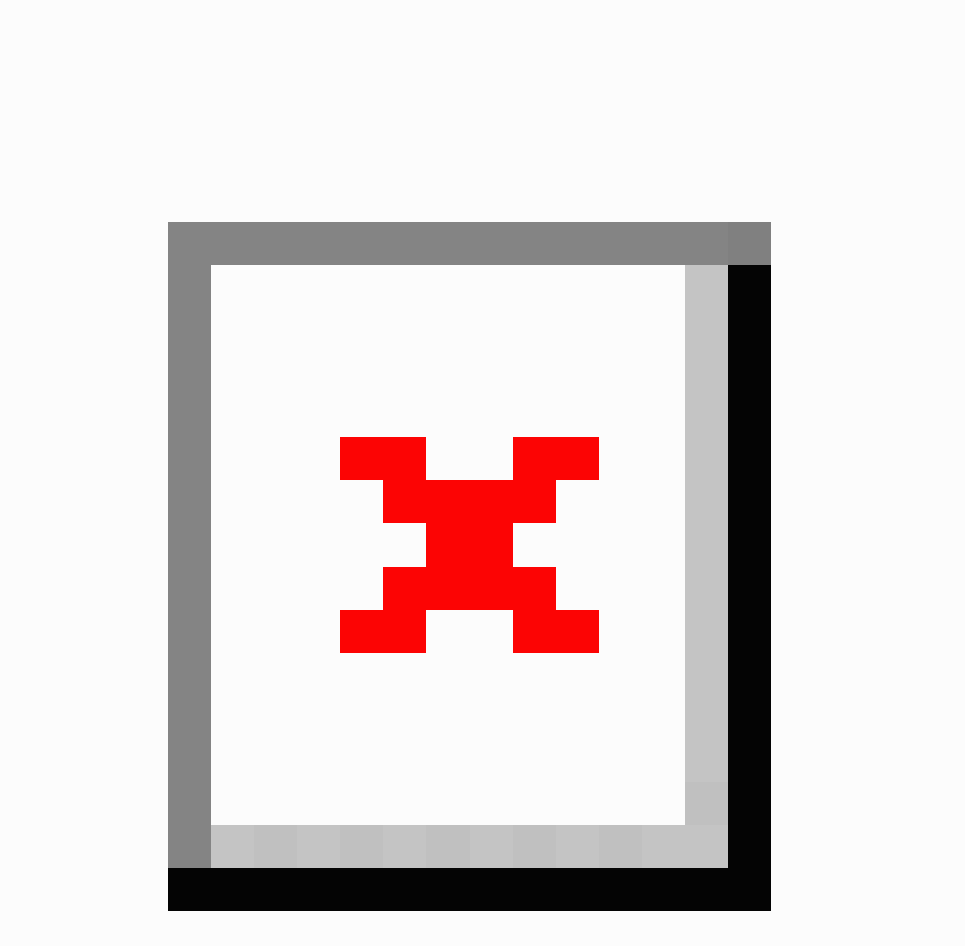
Figure 4. Type of